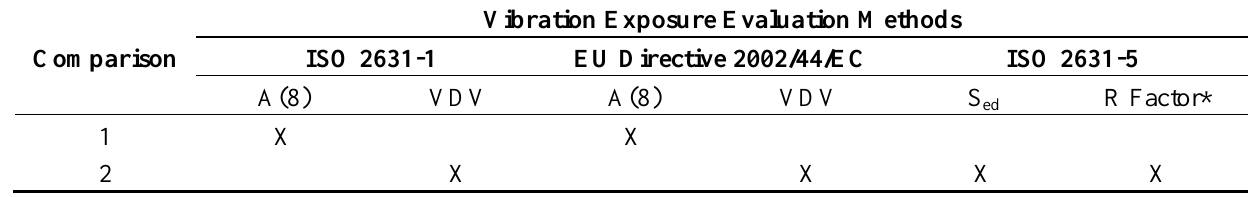
Table 7. Summary of the measures calculated and compared to determine agreement with respect to probability of adverse health